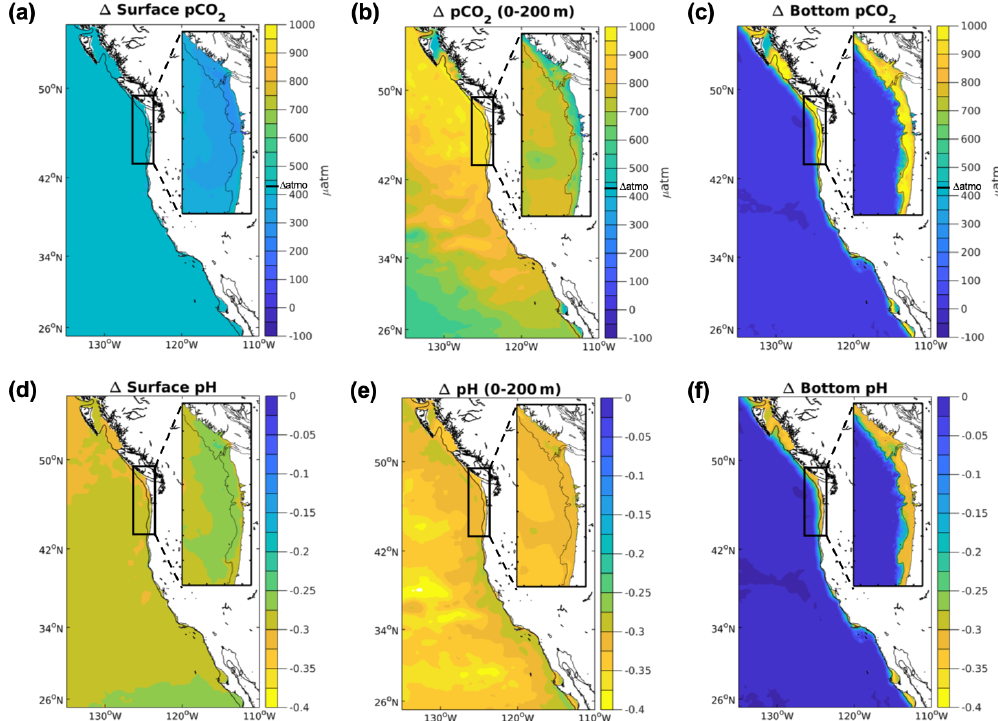
Figure 4. Projected p CO 2 and pH changes in the CCS. Differences between climate stressor variables p CO 2 and pH in the future and the base/present conditions for the 12km (CCS-wide, full panel) and 1.5km (N-CCS, inset) projections for (a) surface p CO 2 (µatm), (b) depth- averaged p CO 2 over the upper 200m (µatm), (c) bottom p CO 2 (µatm), (d) surface pH, (e) depth-averaged pH over the upper 200m, and (f) bottom pH. Positive values indicate a change that is greater in the future than the base/present condition, and negative values indicate lower values in the future than the base/present condition depicted in Fig.